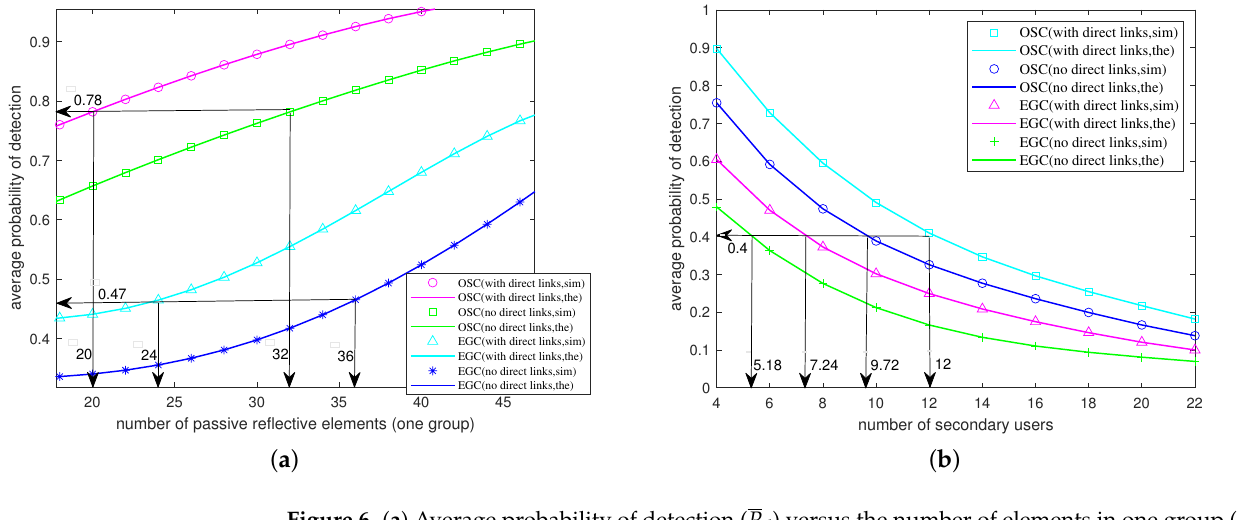
Figure 6. ( a ) Average probability of detection ( P d ) versus the number of elements in one group ( M ). ( b ) Average probability of detection ( P d ) versus the number of secondary users ( L ) for fixed elements in the IRS.